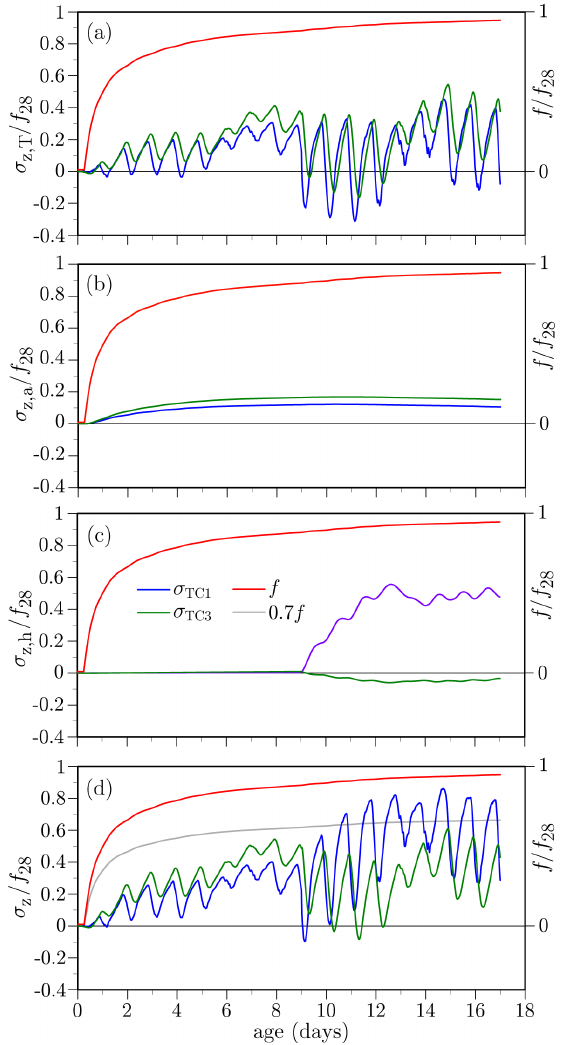
Figure 25. Simulated stresses at mid-deck location in the presence of constraint: ( a ) thermal stress component; ( b ) hygral stress component (due to self-desiccation); ( c ) hygral stress component (due to external drying); ( d ) total